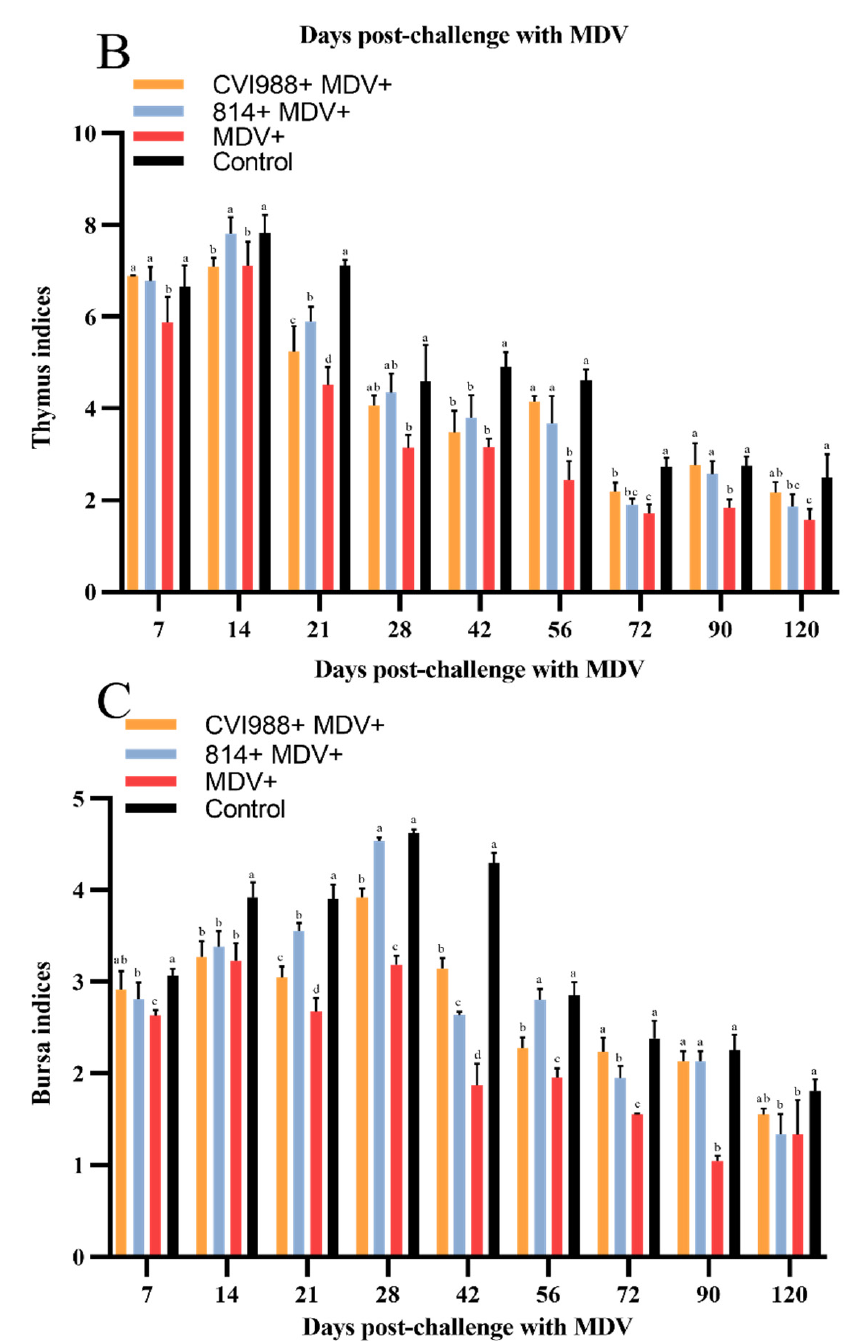
Figure 2. Dynamics of immune organ indices of the experimental birds. (A) spleen; (B) thymus; (C) bursa. Means not sharing a common letter are significantly different ( p < 0.05).